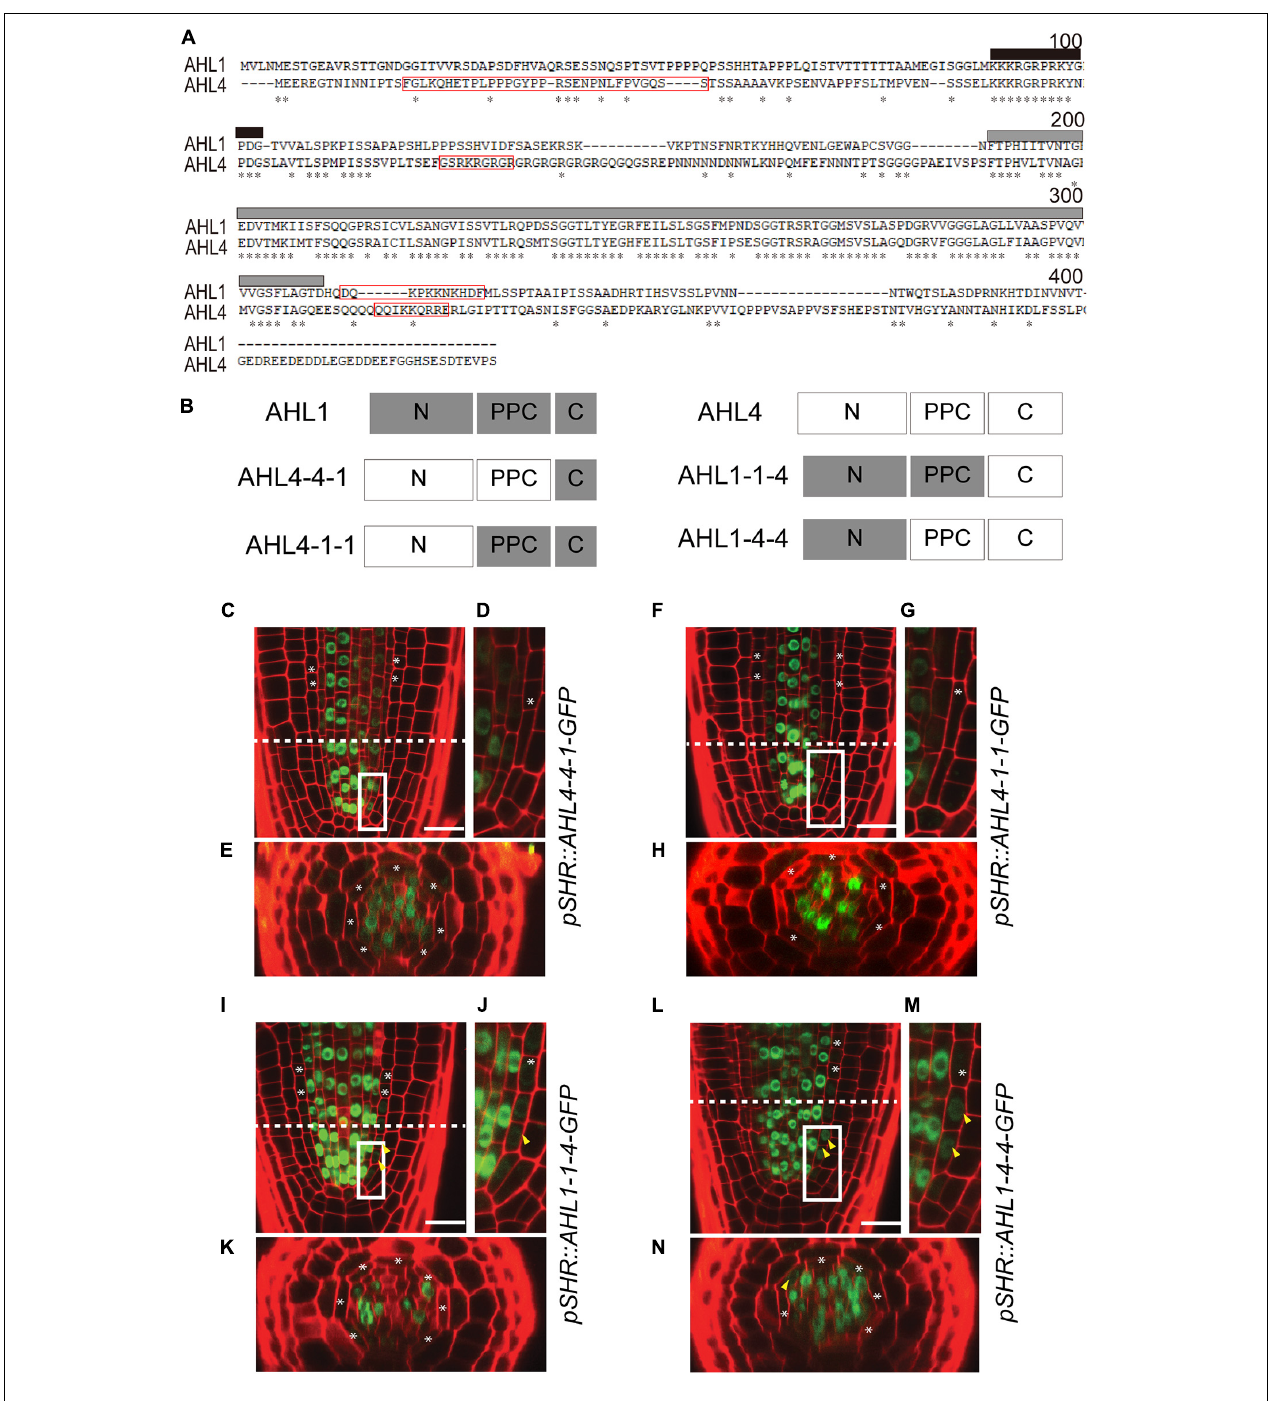
FIGURE 4 | Intercellular movement of AHL1–AHL4 chimeric proteins: (A) Amino acid sequence alignment of AHL1 and AHL4 using the AlignX program (Lu and Moriyama, 2004). Asterisks, identical amino acids; red box; NLS sequence; black box, AT-hook motif; gray box, PPC domain. (B) Schematic illustration of four chimeric proteins between AHL1 and AHL4. Dark gray box, domain from the AHL1 protein; white box outlined in the light gray, domain from the AHL4 protein. (C–N) Confocal microscopy of roots expressing chimeric proteins in the wild type Col-0. (C–E) pSHR:AHL4-4-1-GFP , (F–H) pSHR:AHL4-1-1-GFP , (I–K) pSHR:AHL1-1-4-GFP , and (L–N) pSHR:AHL1-4-4-GFP . (D,G,J,M) Magnified images of regions outlined in white in panels (C,F,I,L) . (E,H,K,N) Cross-sectional images of the dashed-line positions of panels (C,F,I,L) . White asterisks, endodermis; yellow arrowheads, GFP moved into the endodermis; scale bar = 20 µ m.